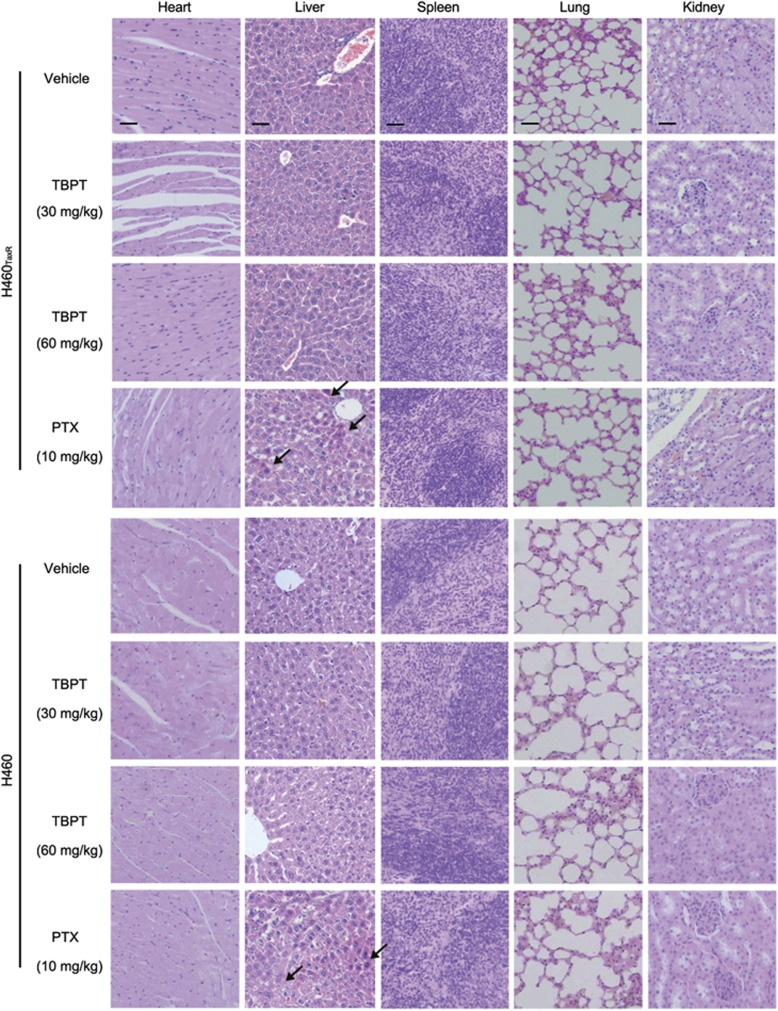
Histopathological examination of the major organs from TBPT or PTX-treated mouse tumor at the end of the experiments. The cross-sections of organs were stained with hematoxylin–eosin. No pathological changes were observed in any group of TBPT-treated mice. Hepatocyte necrosis was observed in some areas in the livers of PTX-treated mice (arrows). The scale bars represent 50 μm and are uniform in each column